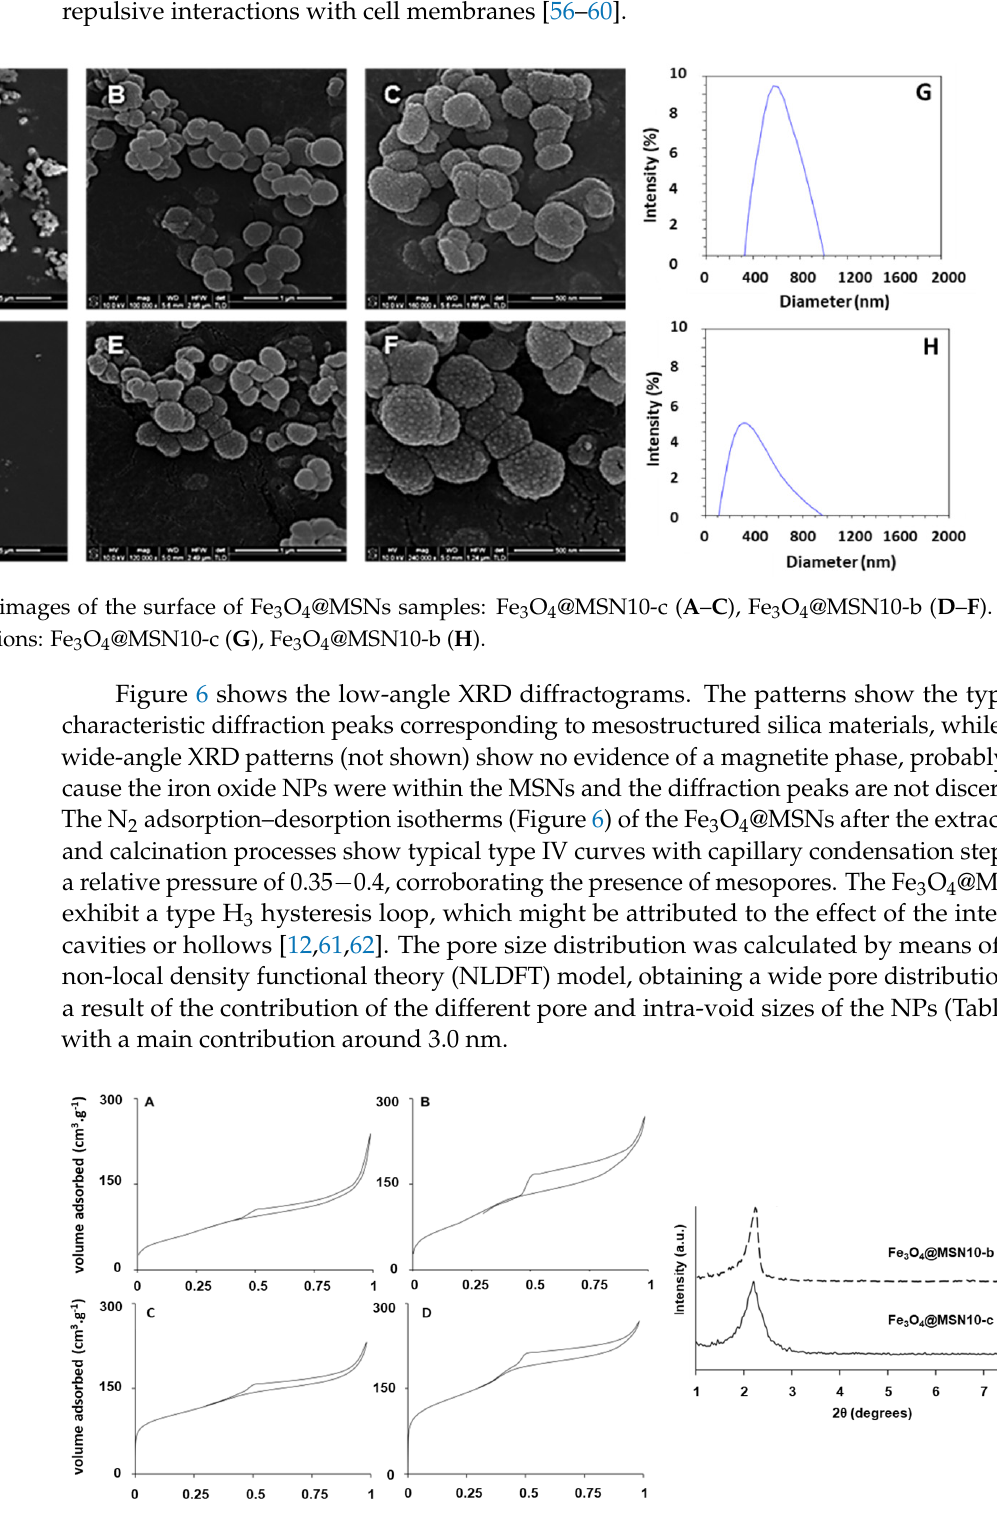
Figure 4. TEM images of the Fe 3 O 4 @MSN10-c ( A – C ) and Fe 3 O 4 @MSN10-b ( D – F ) samples. The black and white arrows correspond to magnetite nanoparticles. STEM image and elemental mapping of Fe and Si of the Fe 3 O 4 @MSN10-b ( G – I ). Elemental analysis in areas corresponding to small particles with dark contrast ( J – K ) and areas with no small particles and clear contrast ( K – L ).